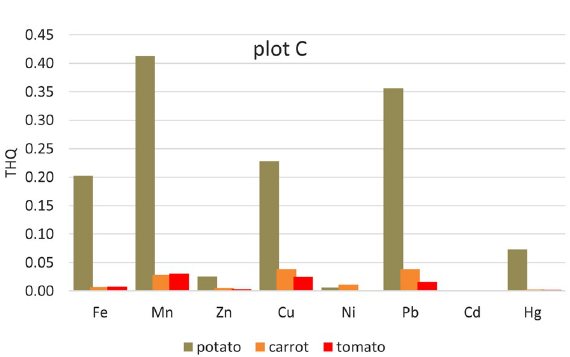
Figure 4. Target hazard quotient (THQ) of heavy metals in potatoes, carrots, and tomatoes grown in plot C.